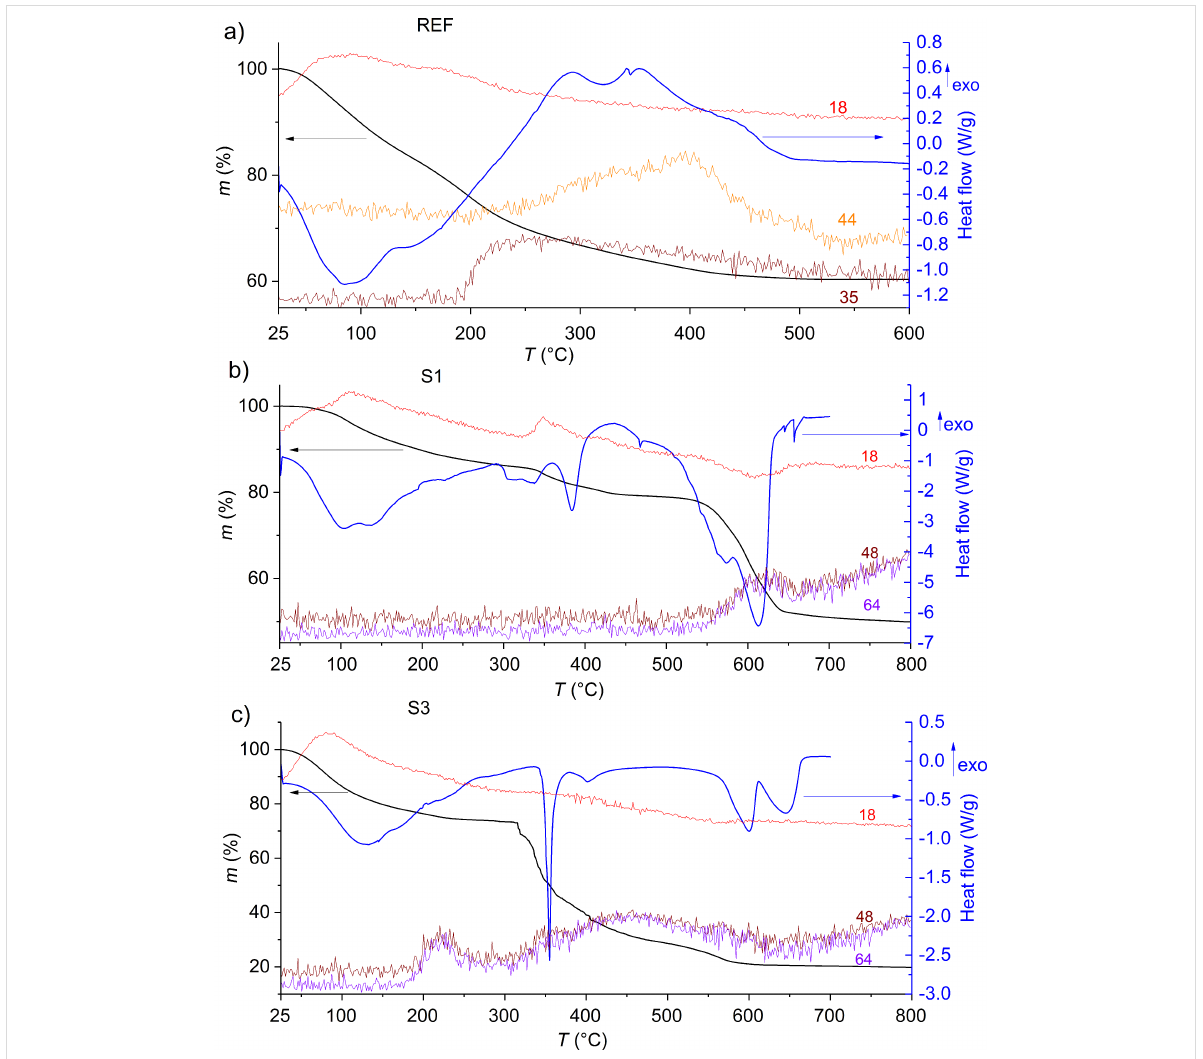
Figure 1: Thermogravimetric analysis–differential scanning calorimetry–mass spectrometry (TGA-DSC-MS) curves of different xerogel samples: a) REF, b) S1 and c) S3.